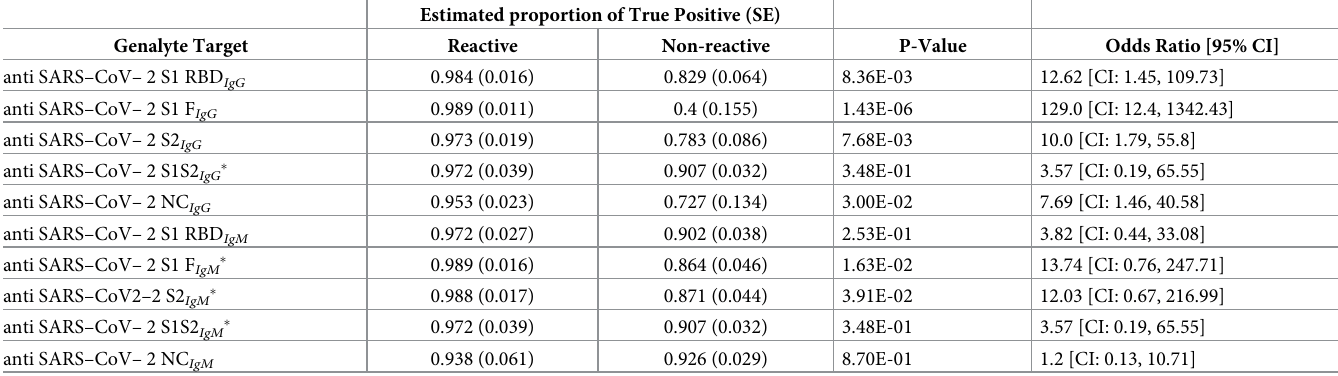
Table 5. Odds ratio of Genalyte target reactivity for true positive versus false negative samples by DiaSorin’s assay. Estimated proportion of True Positive (SE) Genalyte